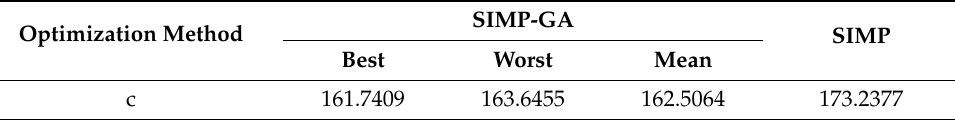
Table 1. Comparison of MBB beam optimization results.